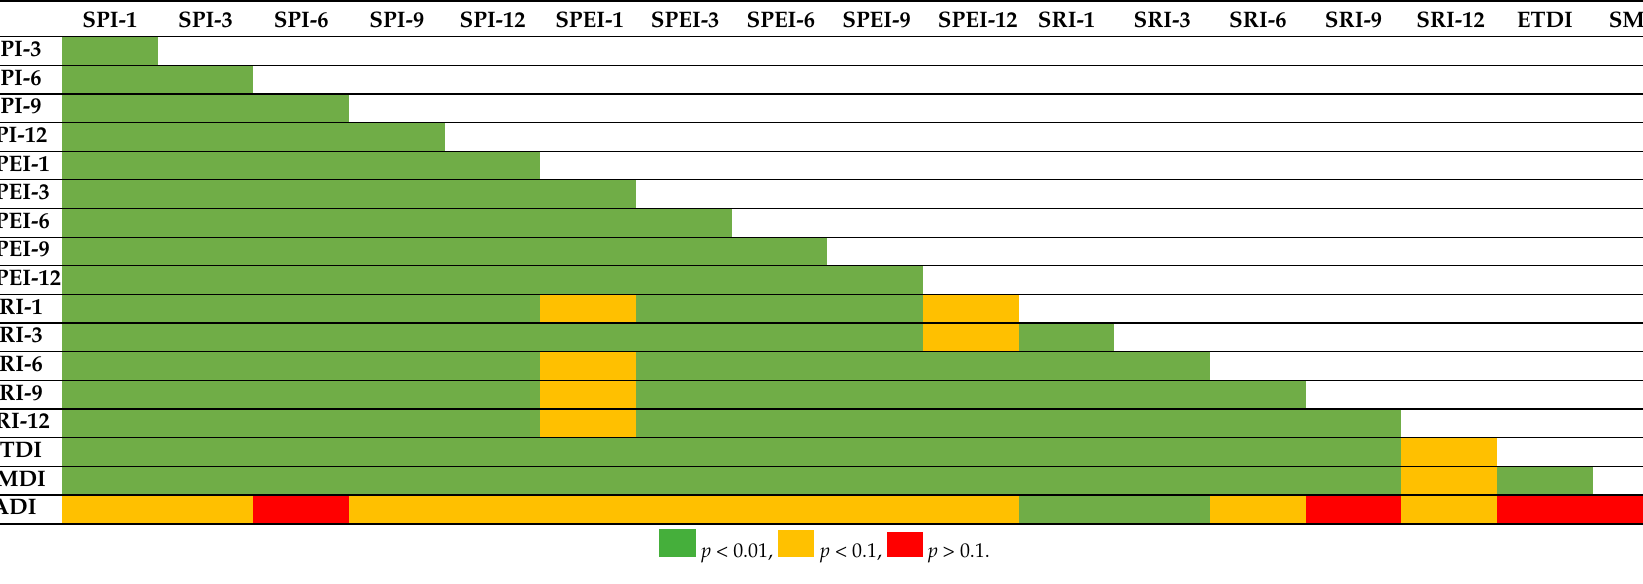
Table 7. The summary of the significant test for the selected 16